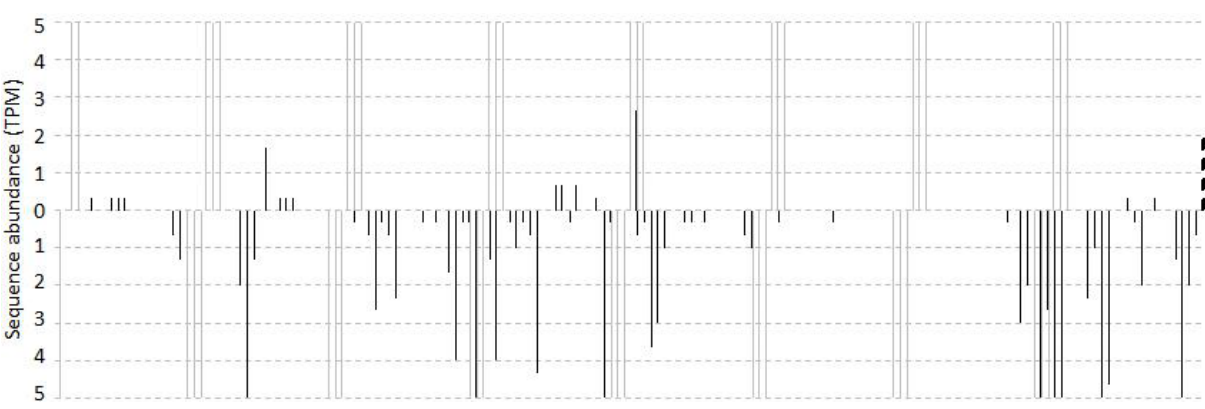
Figure 1. Abundance distribution of sRNAs mapped to vvi TAS3 . The number of reads with a 5' end at each position is plotted. Bars above the sequence represent sense reads; those below represent antisense reads. The cleavage site of vvi-miR390 is marked by a vertical dotted line. Vertical gray lines indicate the miRNA-set 21-nt phased cleavage, allowing a 1-nt offset. Regions with TPMs greater than five are not